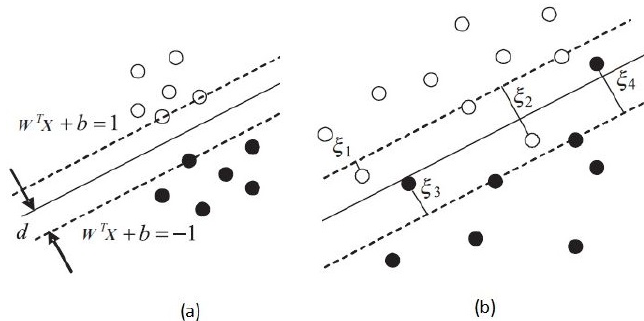
Figure 2. ( a ) Support Vector Machine (SVM) procedure for separating two classes of data by a hyperplane whose distance from the nearest samples of the classes (i.e., the margin d ) is maximized. ( b ) SVM for the non-separable case in which the samples within the margin are penalized